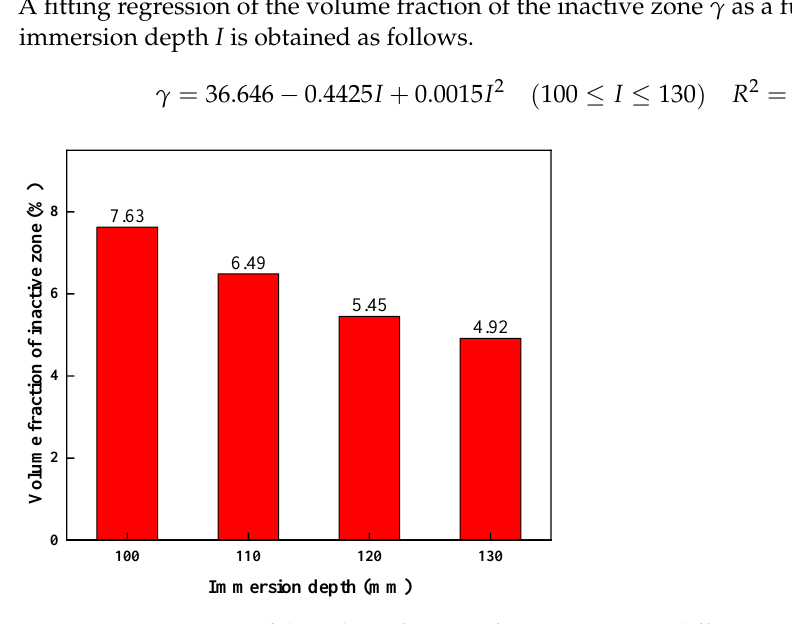
(17) Figure 12. Variation of the volume fraction of the inactive zones at different IRSs.